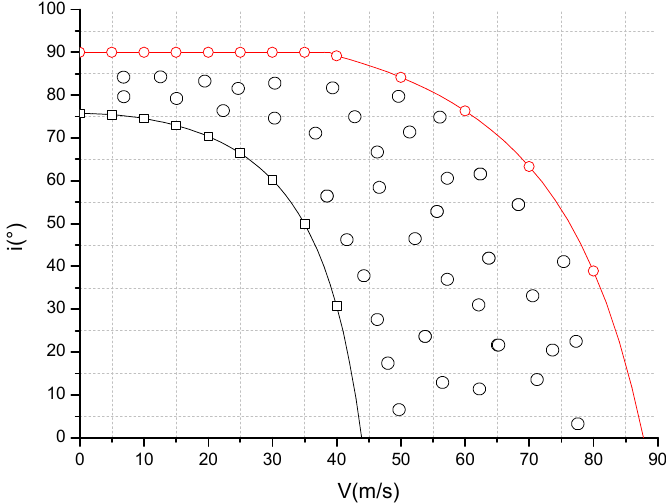
Figure 9. UAV transition corridor.